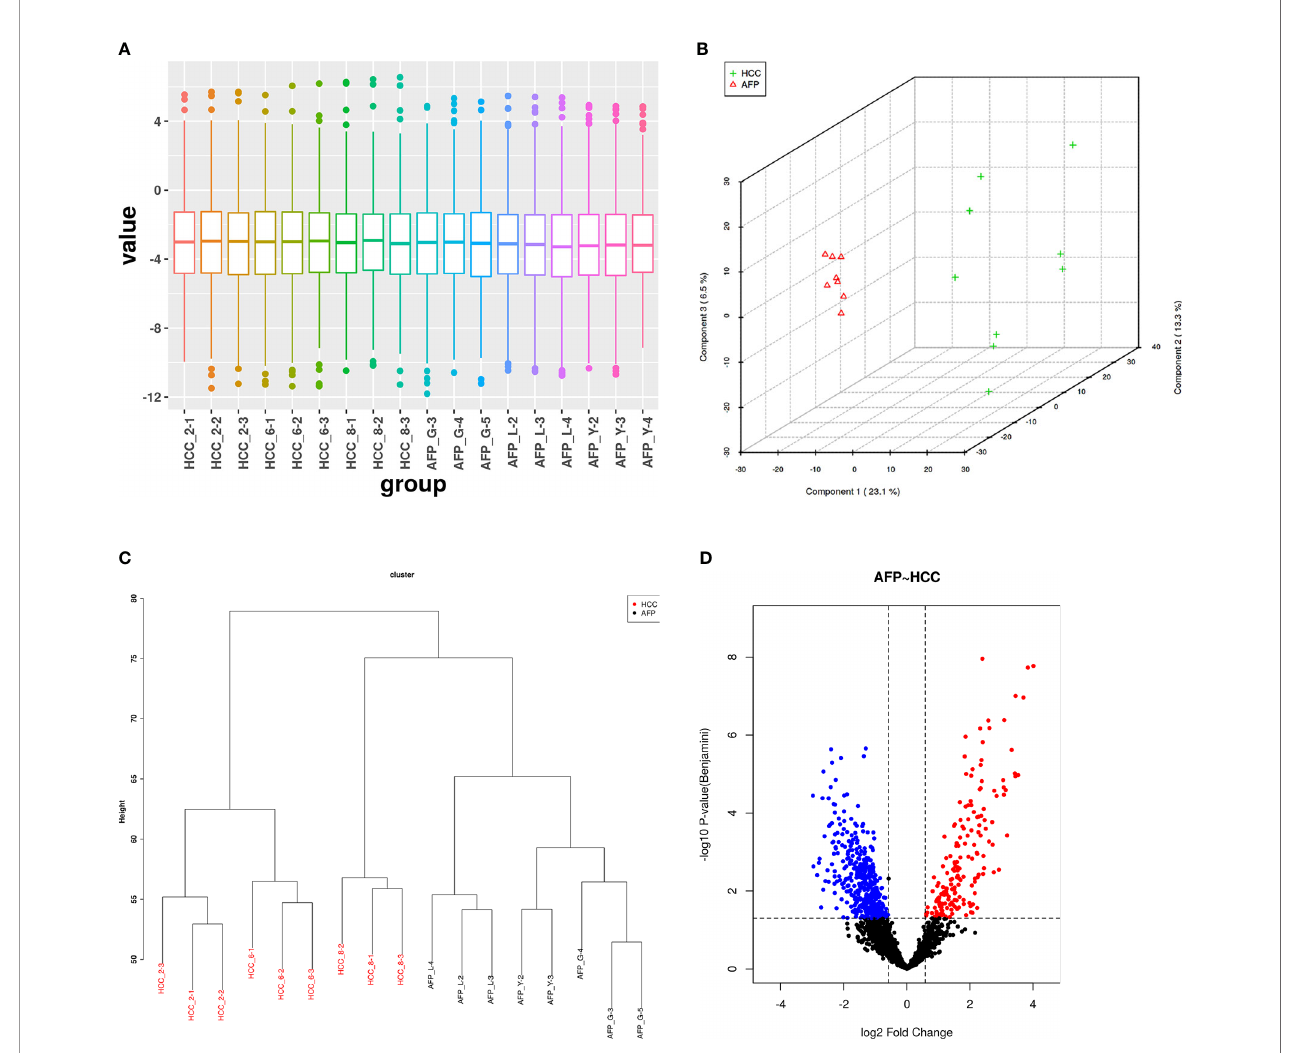
FIGURE 1 | Quality control of SWATH quanti fi cation areas between the alpha-fetoprotein (AFP)-negative hepatocellular carcinoma (HCC) tissue and adjacent tissues. (A) Statistical results of normalized areas. There was signi fi cant speci fi city between the AFP-negative HCC tissue and adjacent tissues by principal component analysis (PCA) and clustering analysis (B, C) . (D) Differentially expressed proteins between the HCC tissue and adjacent